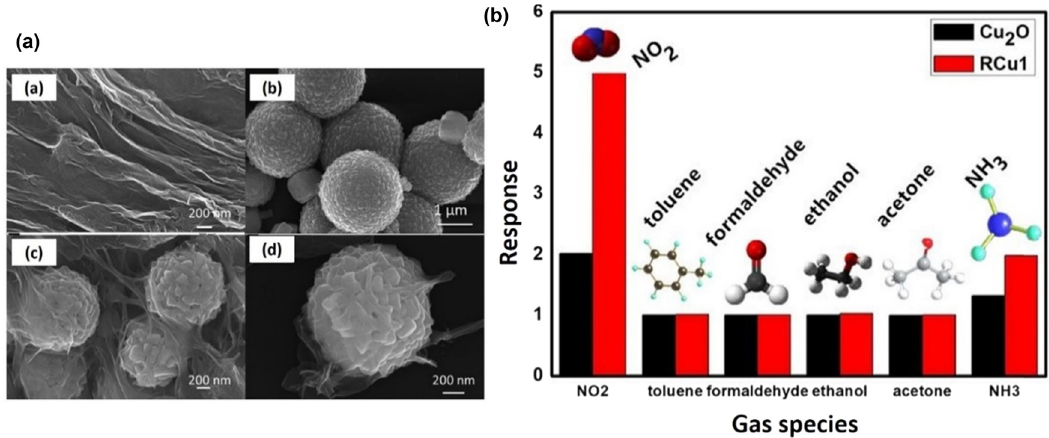
Figure 23: ( a ) FESEM images of ( a ) GO, ( b ) Cu 2 O, and ( c and d ) 1 wt% of rGO/Cu 2 O nanocomposite and ( b ) response of sensor based on Cu 2 O and 1 wt% rGO/Cu 2 O to 1 ppm of di ff erent tested gases at room temperatures. Reproduced from ref. [ 153 ]